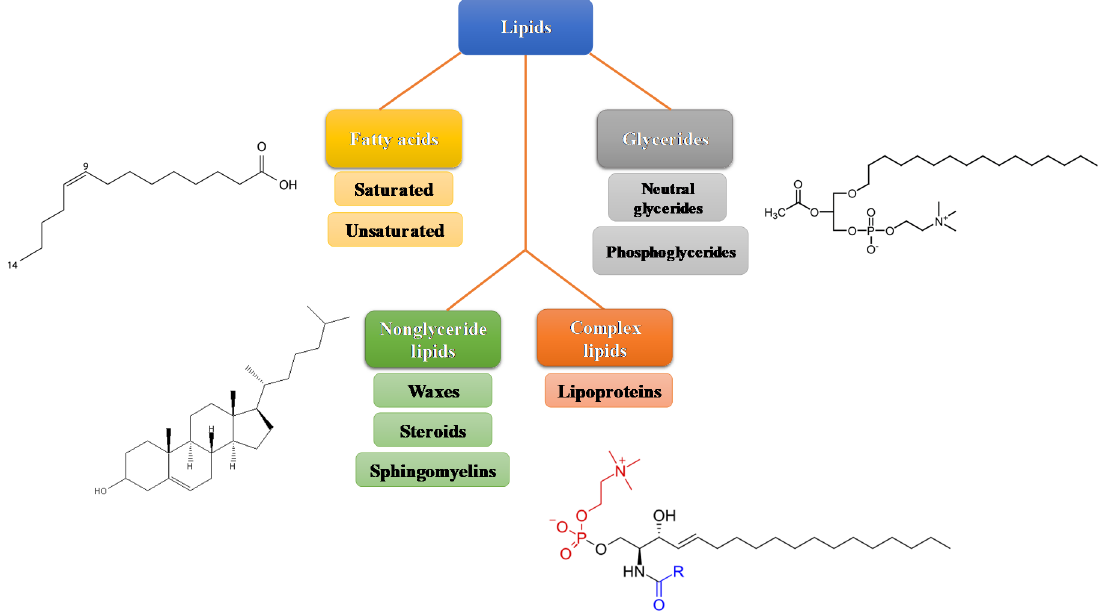
Figure 1. Classification of lipids and basic structure, adapted from [3,6].